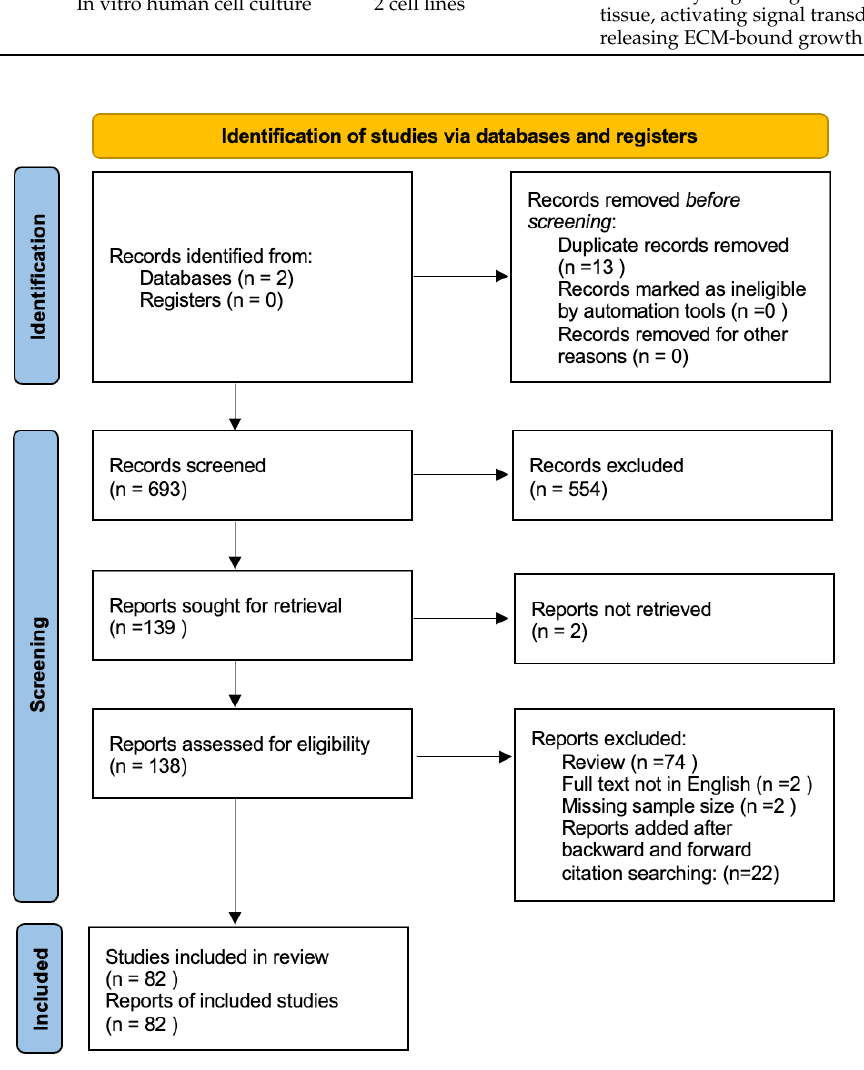
Figure 1. Prisma flowchart summarizing the results of our research.